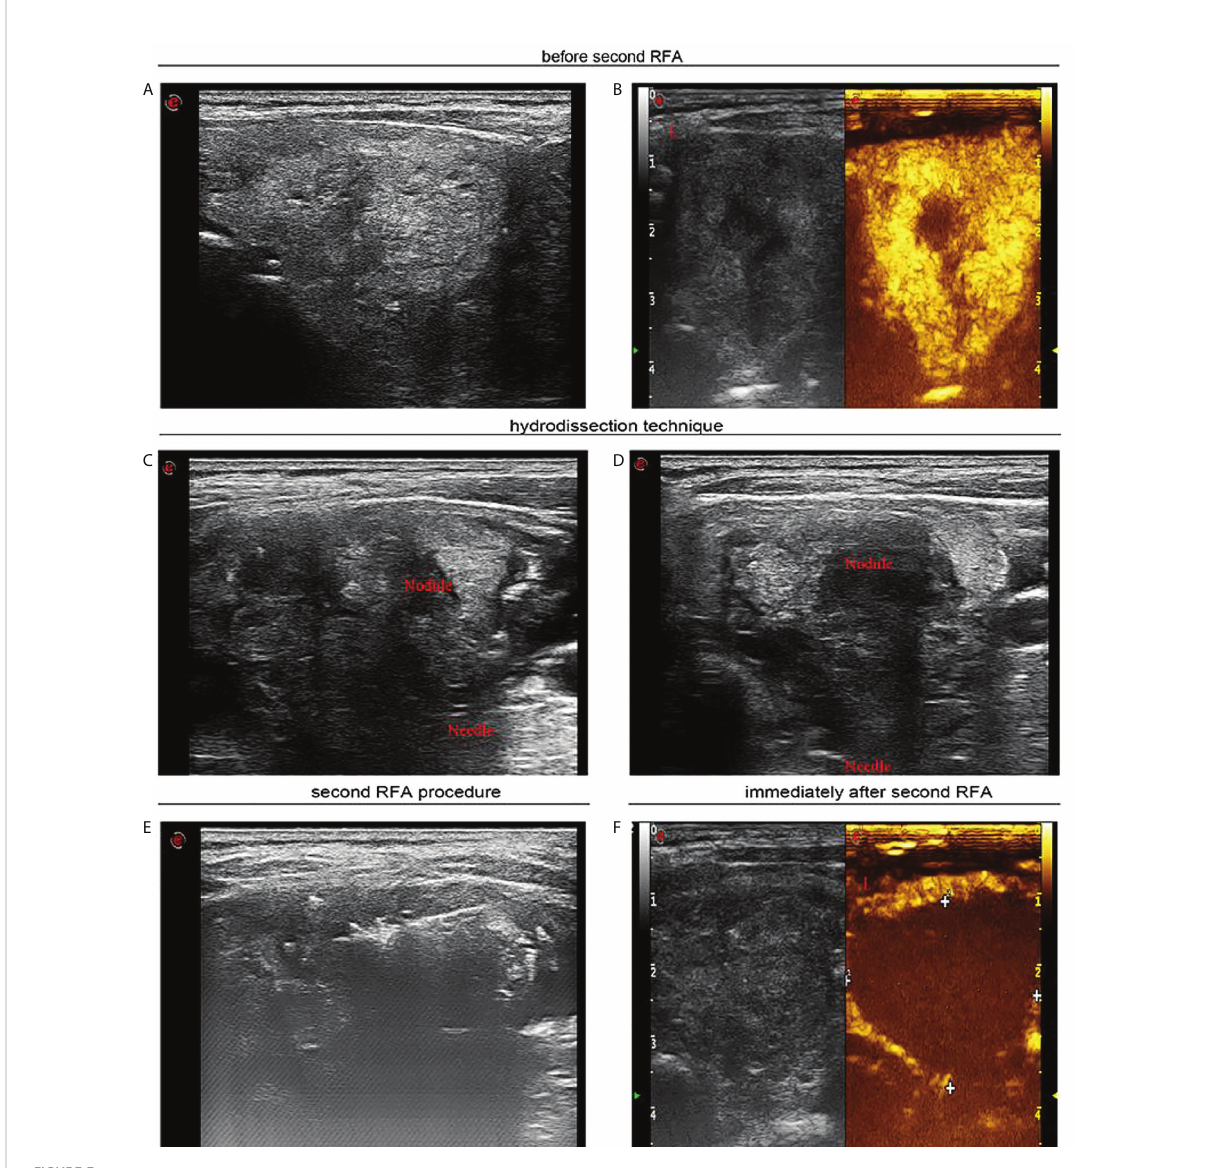
FIGURE 3 Seven months after fi rst radiofrequency ablation, a 55-year-old woman received sequential radiofrequency ablation treatment. (A) Before second radiofrequency ablation ultrasound image in transverse view uncovers a heterogeneous hyperechoic nodule thyroid nodule of 3.5 × 2.6 cm. (B) Contrast-enhanced ultrasound indicates hyperenhancement in peripheral area of the thyroid nodule, and there was no enhancement in the central area of the nodule. (C) Ultrasound image in transverse view indicates that sterile water has reached between thyroid tissue and carotid artery. (D) Ultrasound image in transverse view con fi rmed that sterile water has reached between thyroid tissue and trachea. (E) Ultrasound image in transverse view demonstrates that percutaneous radiofrequency ablation was implemented through moving shot technique. (F) Contrast-enhanced ultrasound shows that immediately after the second radiofrequency ablation, there was no enhancement in the part of the thyroid nodule extending below the